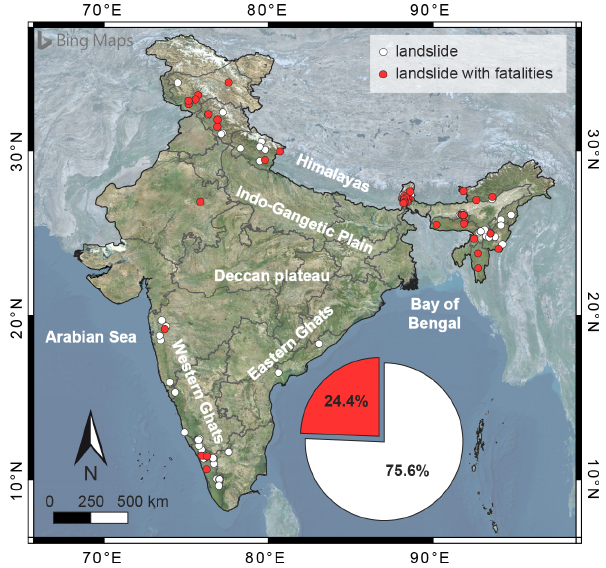
Figure 1. Map of India with the location of landslides triggered by rainfall. Red and white dots highlight the slope failures with and without associated fatalities, respectively. Background image from Bing ©